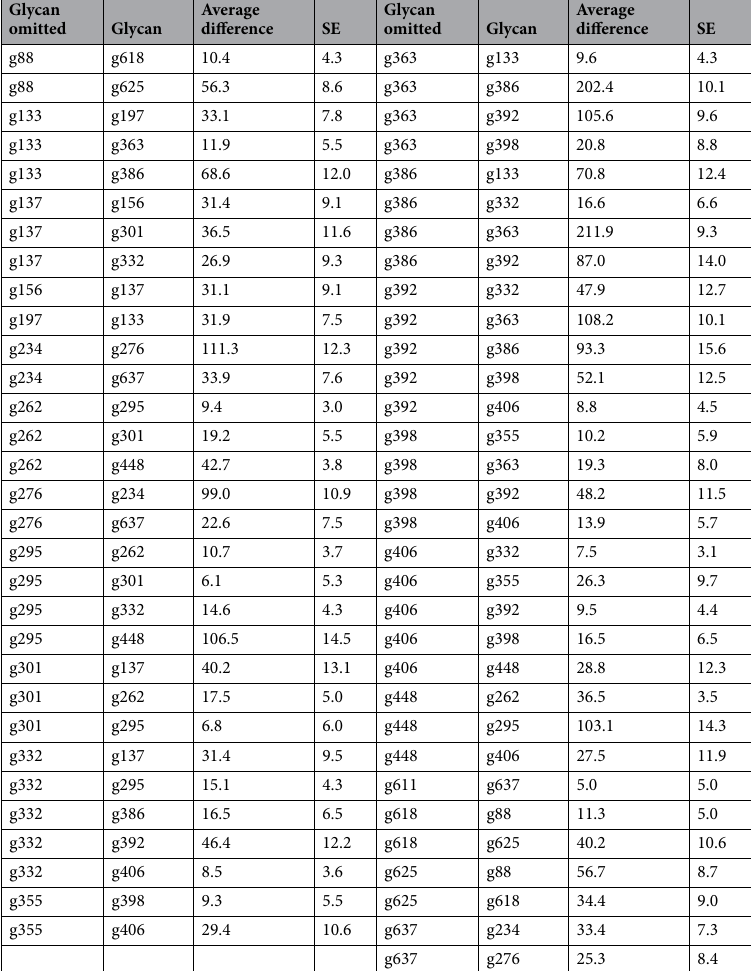
Table 2. Change in solvent accessible surface area (SASA, Å 2 ) of glycans on monomer 1 due to the omission of selected glycans for which the change in SASA was > 5 Å. Average values and standard errors (SE) are shown. Calculation of the change in SASA or AASA was performed by first determining the overall SASA or AASA for all atoms in the Env followed by determination of the SASA or AASA contribution of the individual glycans or protein residues, respectively. This procedure was then repeated with the overall SASA or AASA calculation performed with the individual, selected glycan omitted. The difference between the SASA or AASA values of the glycans or protein residues, respectively, between the truncated and full Env were then